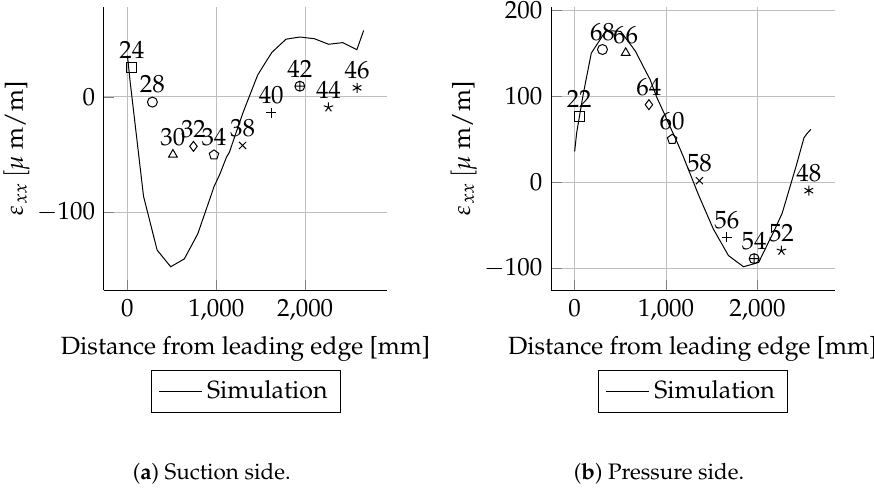
Figure A62. Strain comparison ε LL at radial position R = 5000mm for torsion load case